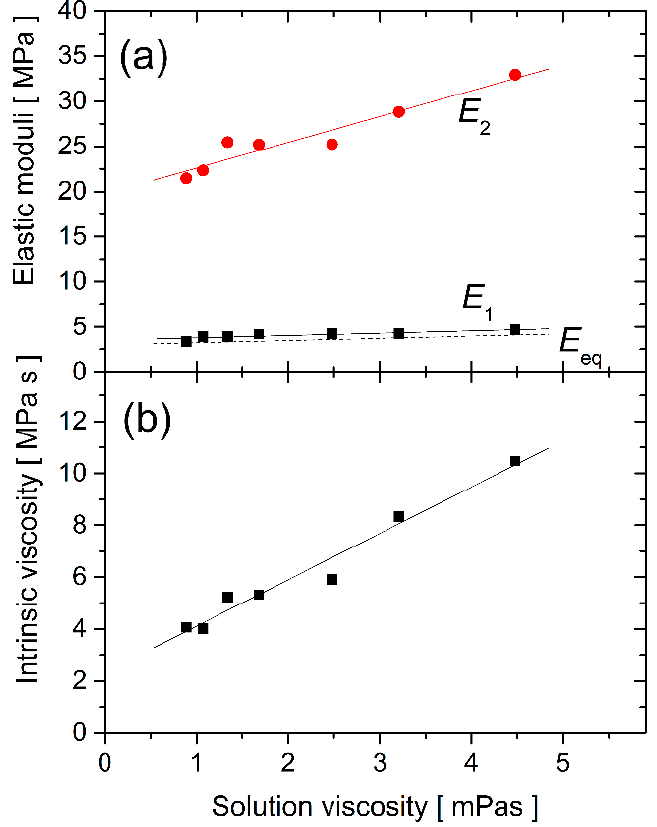
Figure 4. The nanowire material properties: the elastic moduli E 1 , E 2 , and E eq ( a ), and the intrinsic viscosity η i ( b ), are plotted against the glucose solution viscosity.